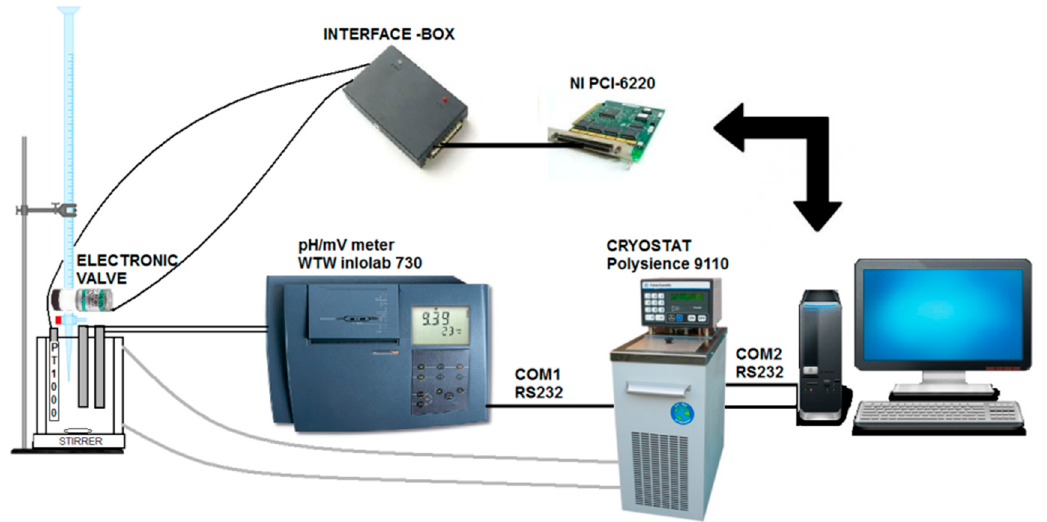
Figure 1. Configuration of the semi-automated setup for thermostatically controlled potentiometric measurements.